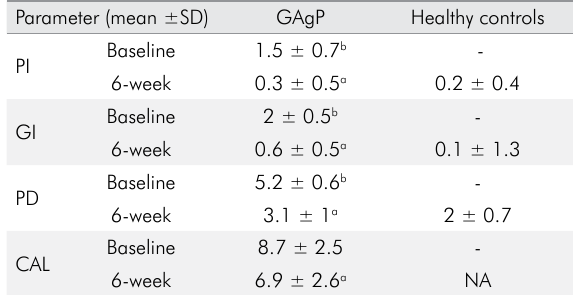
Table 3. Clinical parameters at baseline and 6-week for study groups (mean ±